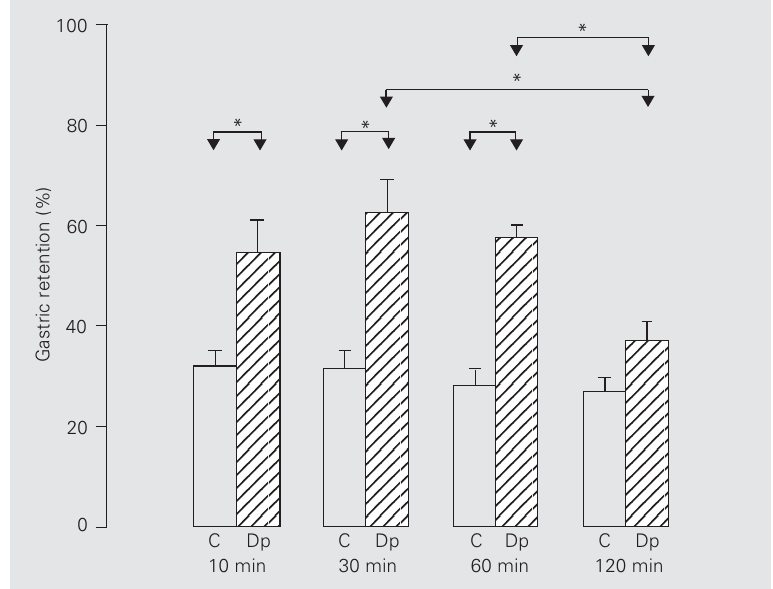
Figure 2. Gastric retention (%), reported as mean ± SEM, of a saline test meal determined 10 min after administration to rats by gavage. The animals (N = 5) received iv vehicle (C) or 80 mg/kg dipyrone (Dp) 10, 30, 60 and 120 min before the determination of gastric retention. *P < 0.01 for the comparisons indicated by the arrows (Tukey test).